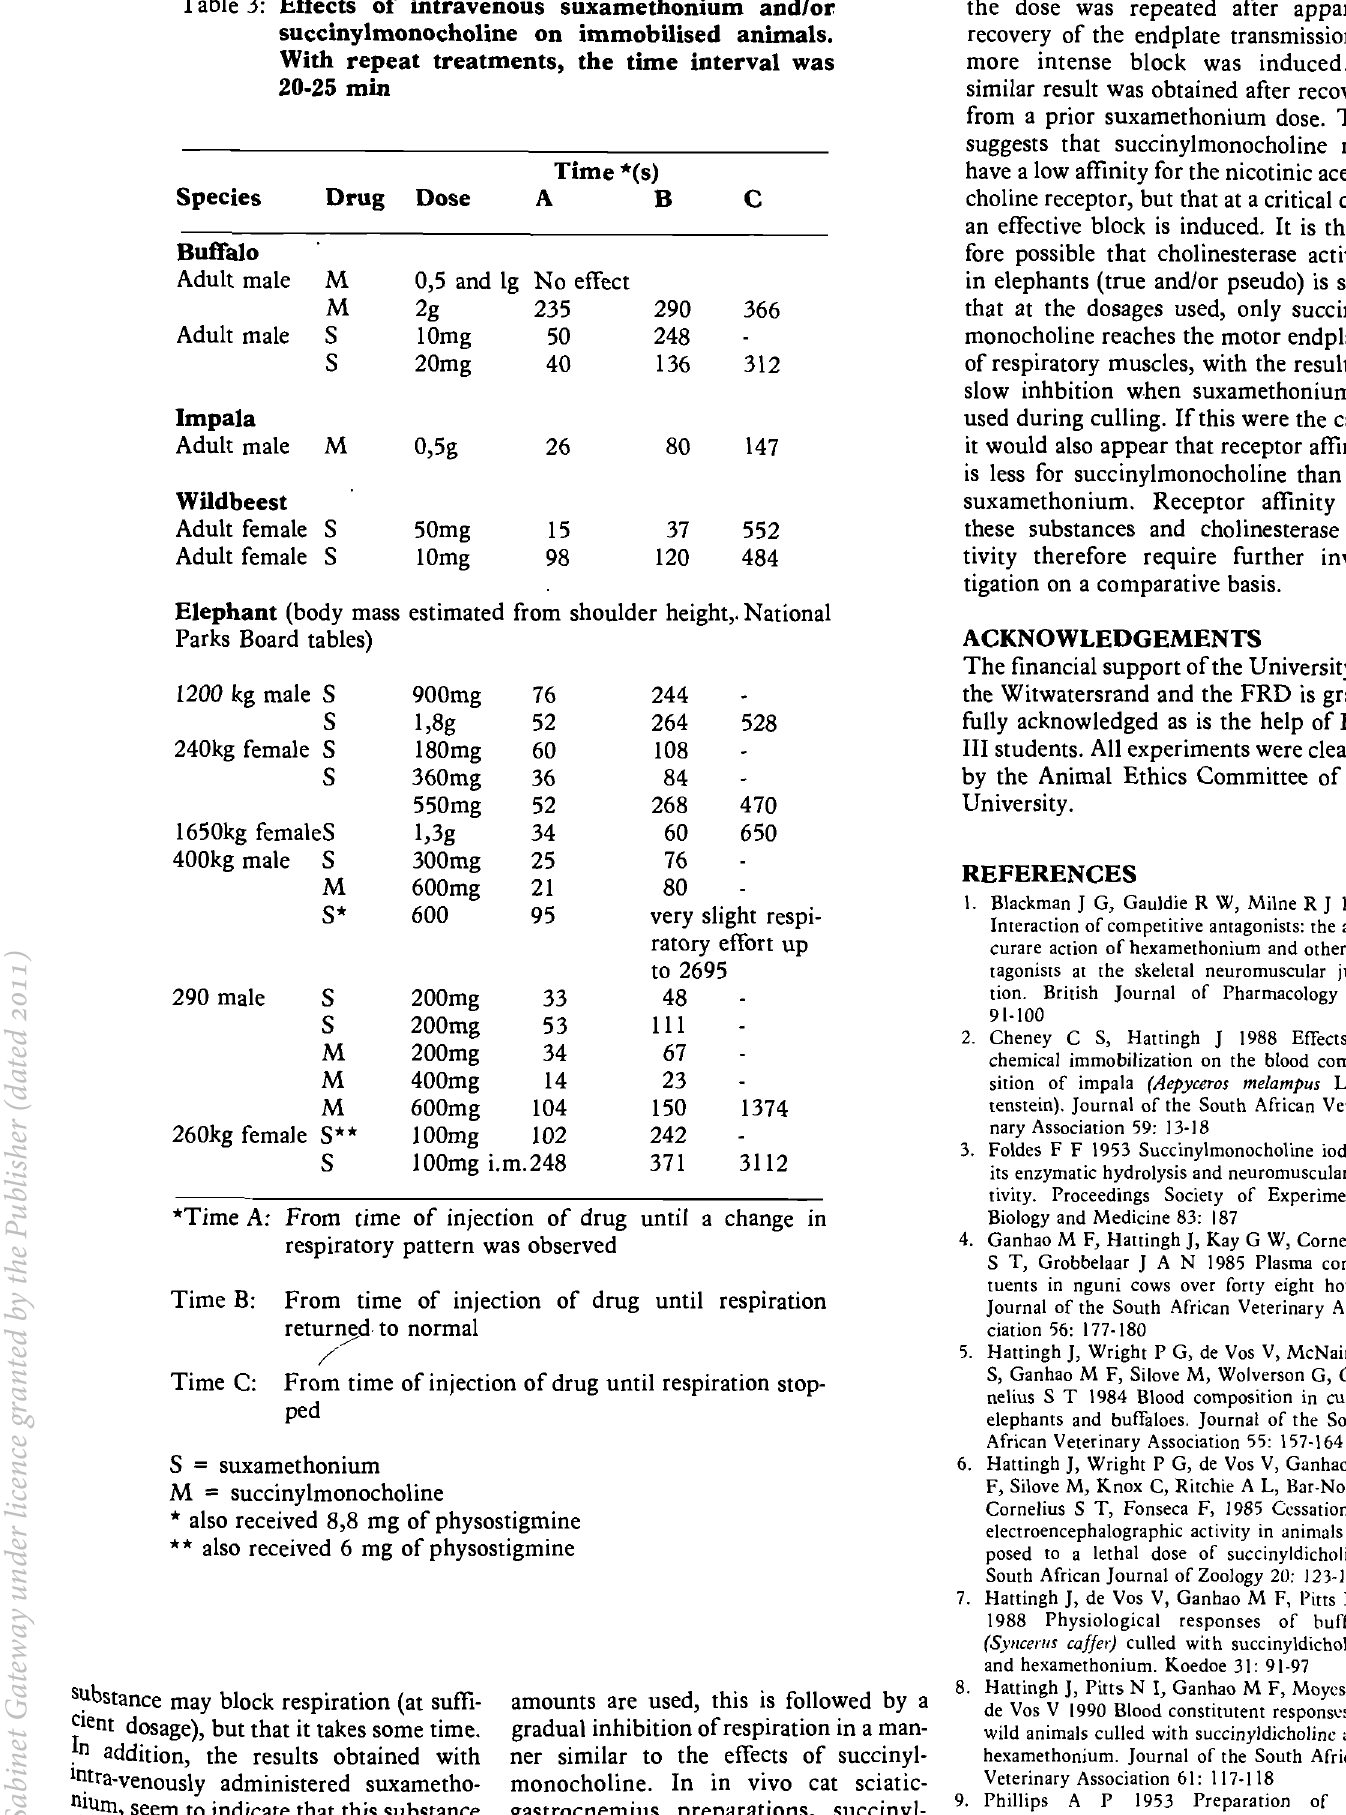
Table 3: Effects of intravenous suxamethonium and/or succinylmonocholine on immobilised animals. With repeat treatments, the time interval was 20·25